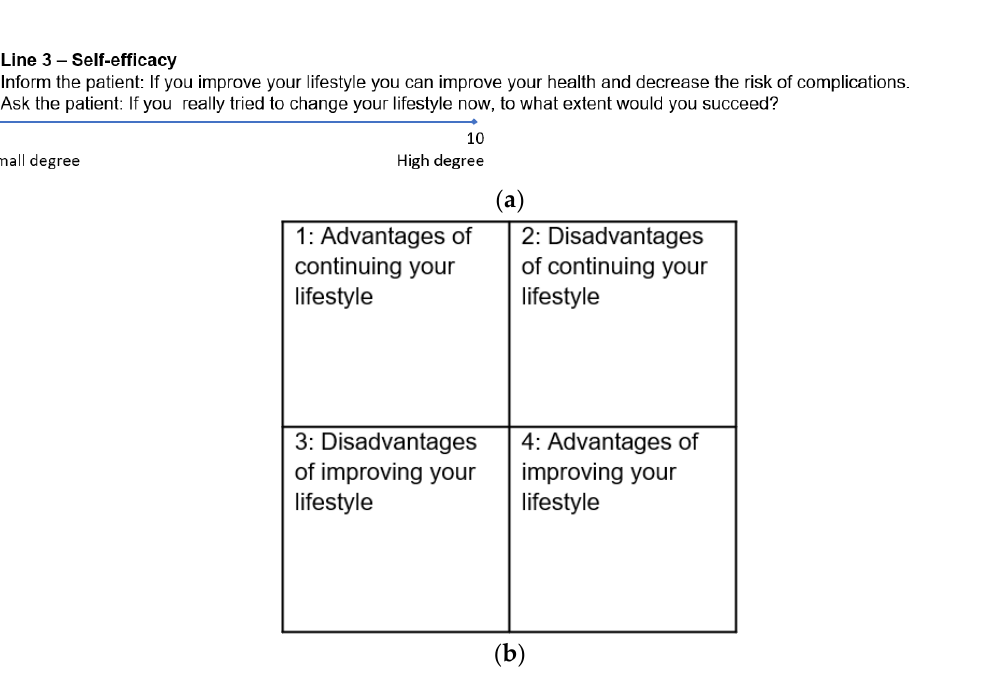
Figure 2. ( a ) The Line Tool (0 – 10 cm) [10], ( b ) The Box Tool (part 1 – 4) [10].